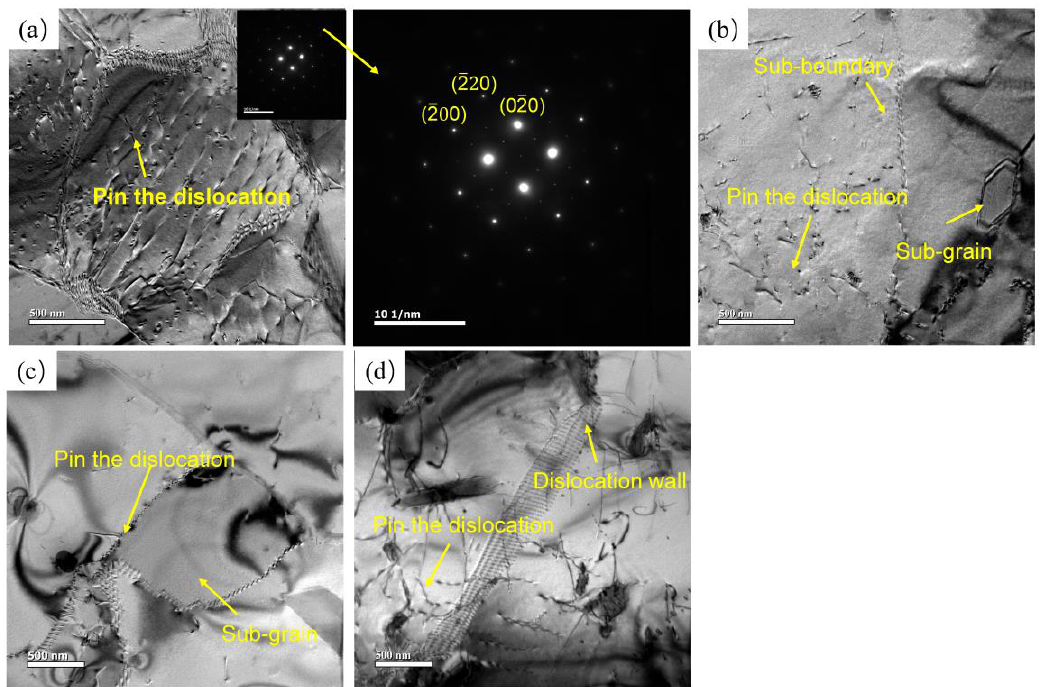
Figure 8. TEM microstructure at different deformation temperatures at 0.01 s − 1 : ( a ) 350 °C/0.01 s − 1 ; ( b ) 400 °C/0.01 s − 1 ; ( c ) 450 °C/0.01 s − 1 ; ( d ) 500 °C/0.01 s − 1 . ( b ) 400 ◦ C/0.01 s − 1 ; ( c ) 450 ◦ C/0.01 s − 1 ; ( d ) 500 ◦ C/0.01 s − 1